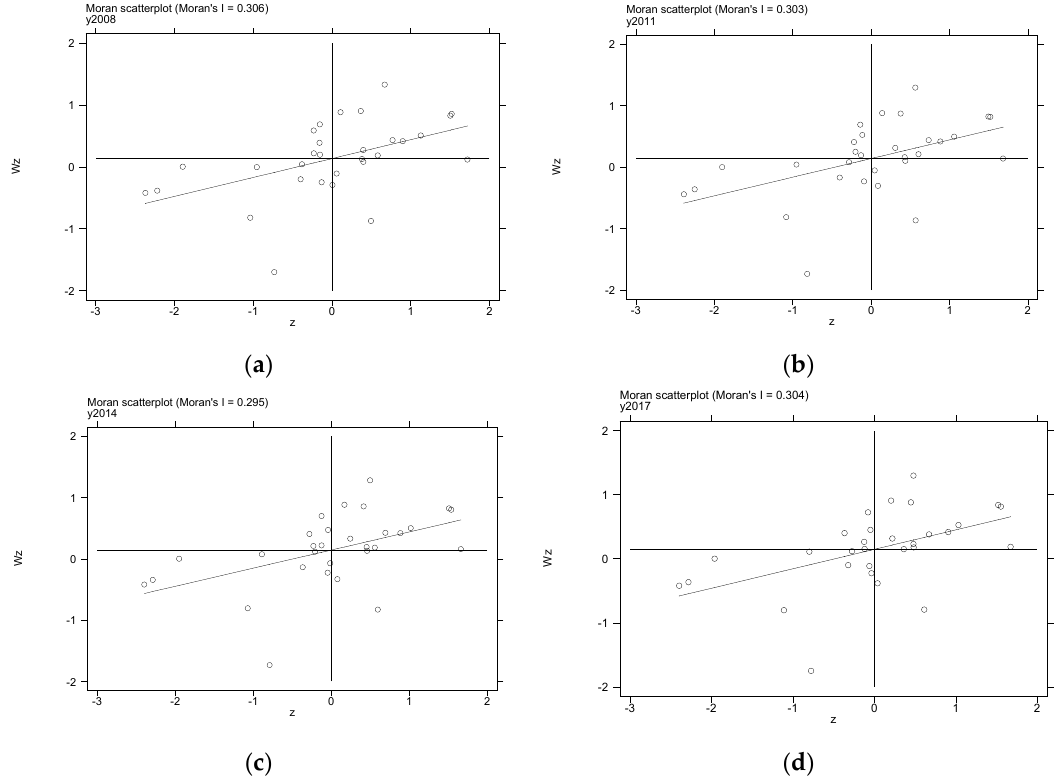
Figure 2. Scatter plots of Moran’s I of economic growth in China. ( a ) Description of scatter plots of Moran’s I of economic growth of China in 2008; ( b ) Description of scatter plots of Moran’s I of economic growth of China in 2011; ( c ) Description of scatter plots of Moran’s I of economic growth of China in 2014; ( d ) Description of scatter plots of Moran’s I of economic growth of China in 2017.